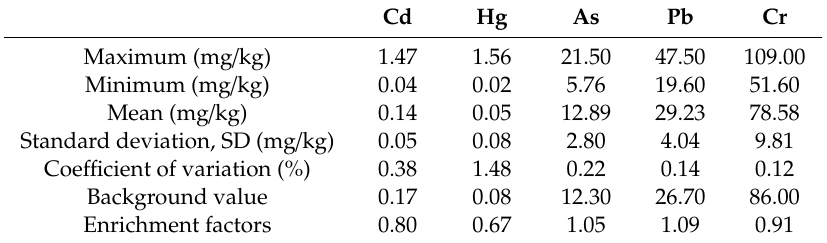
Table 3. Compendium statistics of concentrations of PTEs in soil at 1109 points in Xiangzhou. Cd Hg As Pb Cr